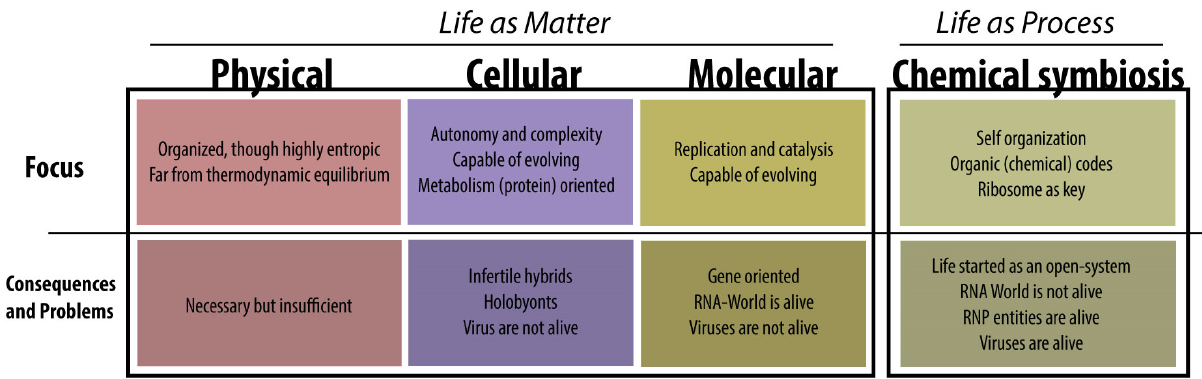
Figure 1 - “Life as Matter” versus “Life as Process” scenarios: Central ideas and consequences for the main approaches to the concept of